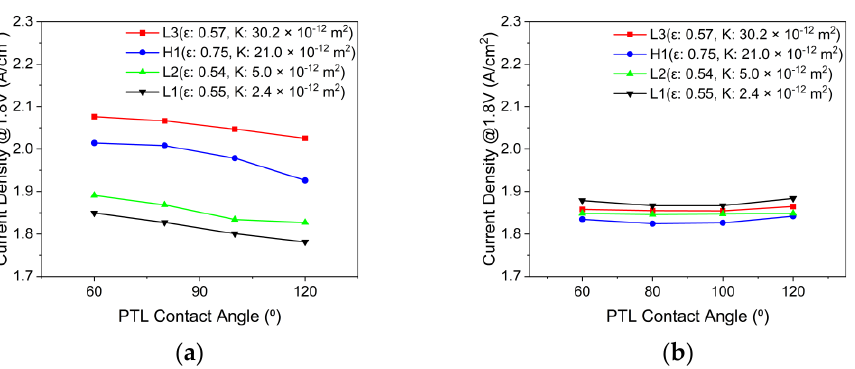
Figure 13. Effects of the PTL properties on PEMWE’s current density with ( a ) the channel flow field and ( b ) the PTL flow field ( 𝑄̇ 𝑖𝑛 : 10 sccm, T in : 328.15 K, T cell : 328.15 K, V op : 1.8 V and 𝑔 : z+).